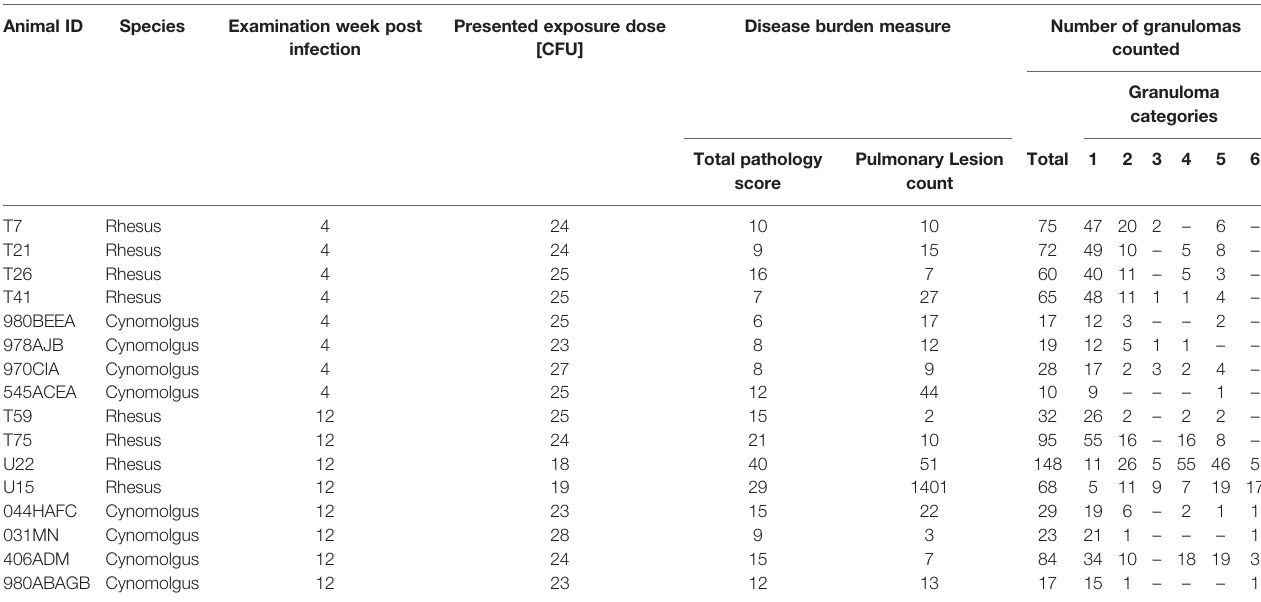
Total pathology score = gross pathology. Pulmonary lesion count = whole lung gross count. Granulomas counted = right upper and left lower lung lobes